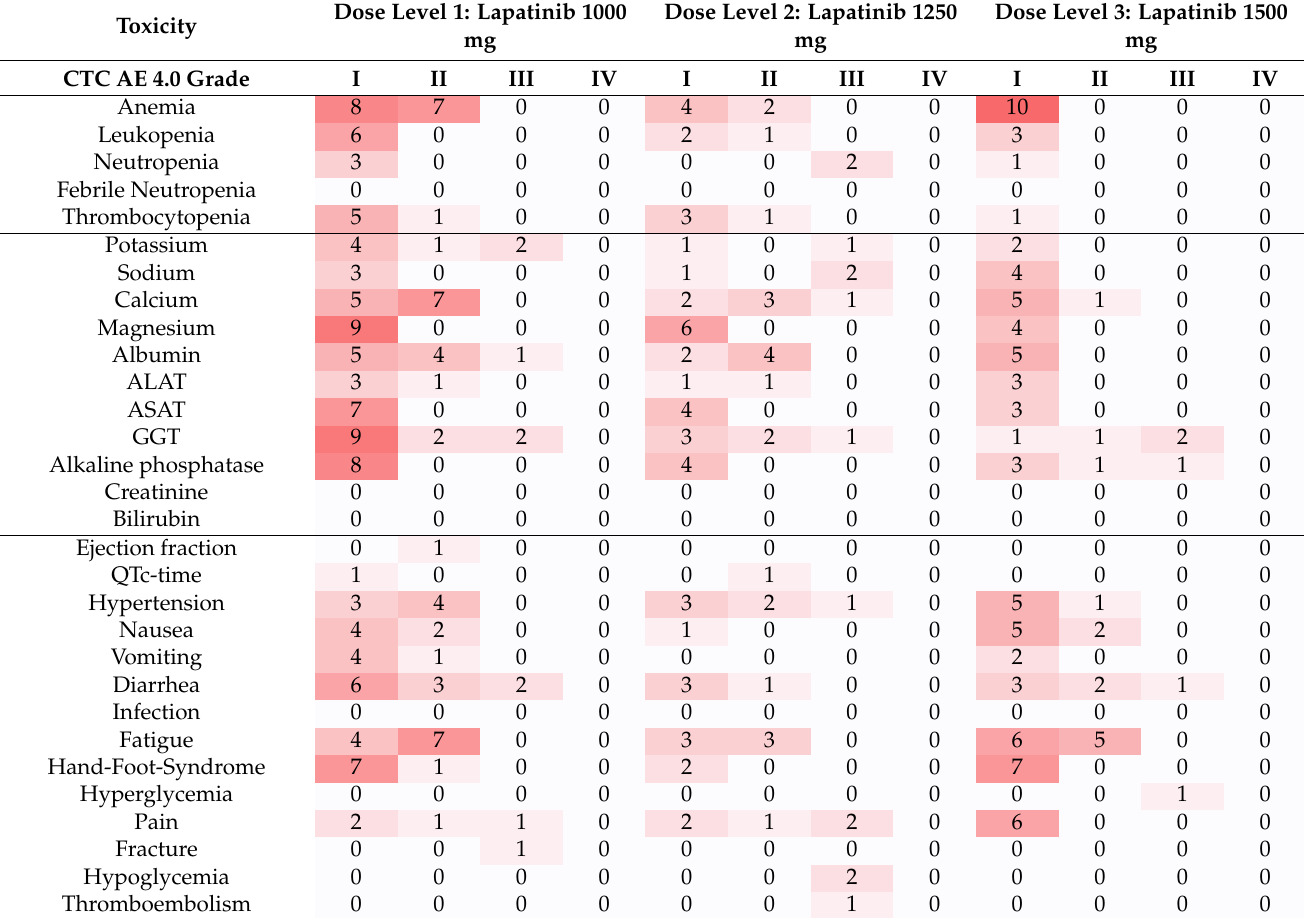
Heat map: The color intensity indicates the number of patients with toxicity. The darker the color, the higher the number of